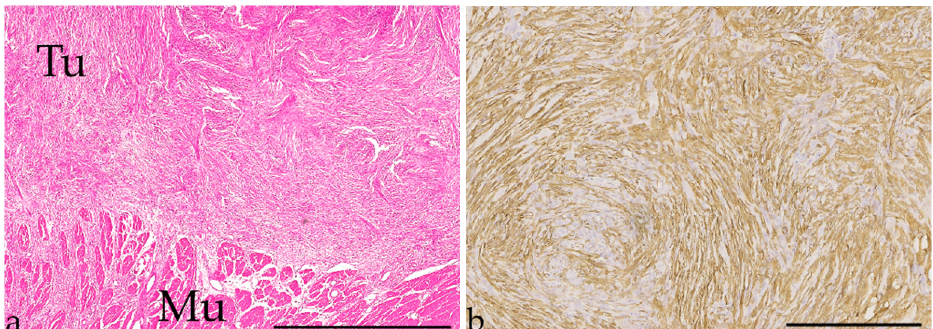
Figure 6. Intestinal leiomyosarcoma. ( a ): Histology of a spindle cell tumour (Tu) with invasive growth into the muscularis (Mu) of an 11-year-old male castrated DSH; (HE stain, bar = 2 mm). ( b ): Immunohistochemistry of the same tumour shows an intense expression of smooth-muscle alpha-actin in the neoplastic cells (leiomyosarcoma, IHC, bar = 300 µm).